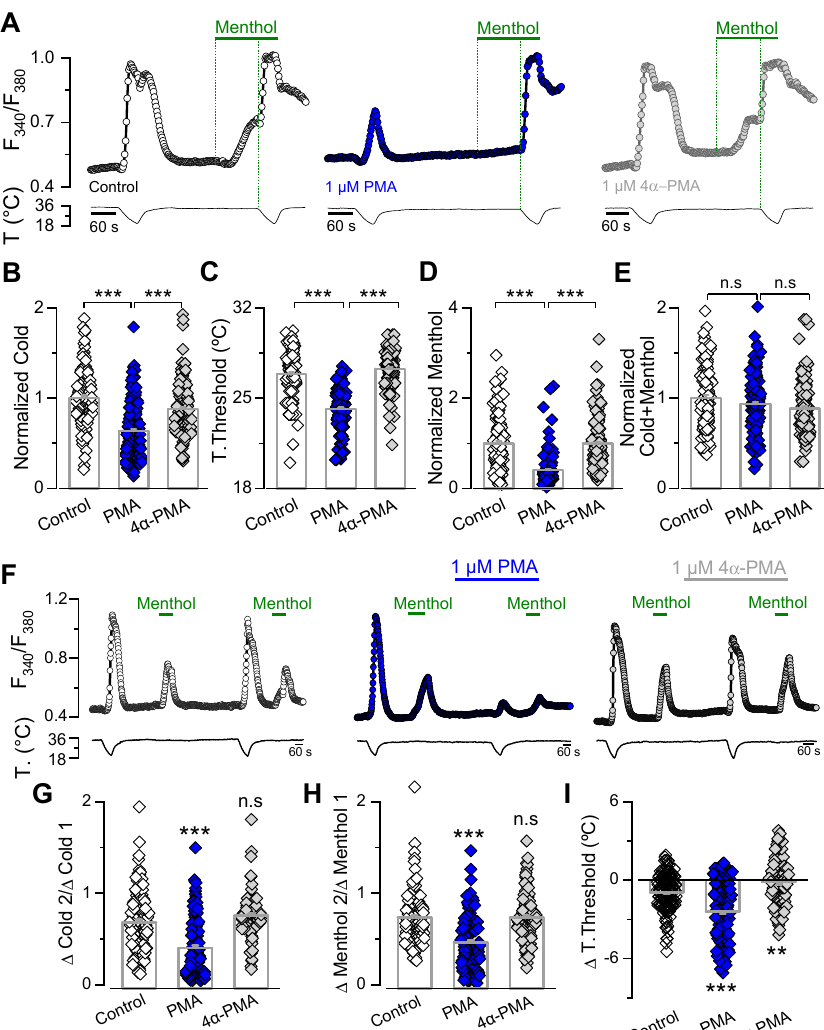
Figure 1. TRPM8 responses to cold and menthol are reduced by PMA-induced PKC activation. ( A ) Representative ratiometric [Ca 2+ ] i traces showing responses of HEK-293-mTRPM8-myc stable cell line to cold, 100 µM menthol, and cold in the presence of 100 µM menthol. Cells were preincubated for 10 min at 37 °C with control solution (left, open circles), 1 µM PMA (central panel, blue circles) and 1 µM 4 α -PMA (right panel, grey circles). In each condition, the upper trace shows [Ca 2+ ] i and the lower trace represents bath temperature. Green vertical dotted lines indicate the start of menthol and cold plus menthol stimuli. ( B – E ) Bar graph representing mean and S.E. and data points of cold- ( B ), temperature threshold ( C ), menthol- ( D ), and cold+menthol-induced responses ( E ) for each condition. The values were normalized to the mean response observed in control condition. Control, n = 119; PMA, n = 149 and 4 α -PMA, n = 146. Statistical significance was assessed using a one-way ANOVA test in combination with a Bonferroni’s post hoc test; *** p < 0.001 and n.s. (not significant) p > 0.05. ( F ) Representative Fura-2 ratiometric [Ca 2+ ] i traces showing responses of HEK-293-mTRPM8-myc cells to cold and menthol stimuli under control conditions (left panel) and before and following treatment with 1 µM PMA (central panel) or 1 µM 4 α -PMA (right panel). ( G – H ) Bar graph representing mean and S.E. and data points of ratio responses to cold ( Δ C2/ Δ C1) ( G ) and menthol ( Δ M2/ Δ M1) ( H ) for each condition. ( I ) Summary of the effect of different treatments on the temperature threshold of cold-evoked responses (T2-T1). Negative values indicate shifts towards lower temperatures. Control, n = 134; PMA, n = 130 and 4 α -PMA, n = 112. Statistical significance was assessed using a one-way ANOVA test in combination with a Dunnett’s post hoc test; *** p < 0.001, ** p < 0.01 and n.s. p > 0.05, compared to control.